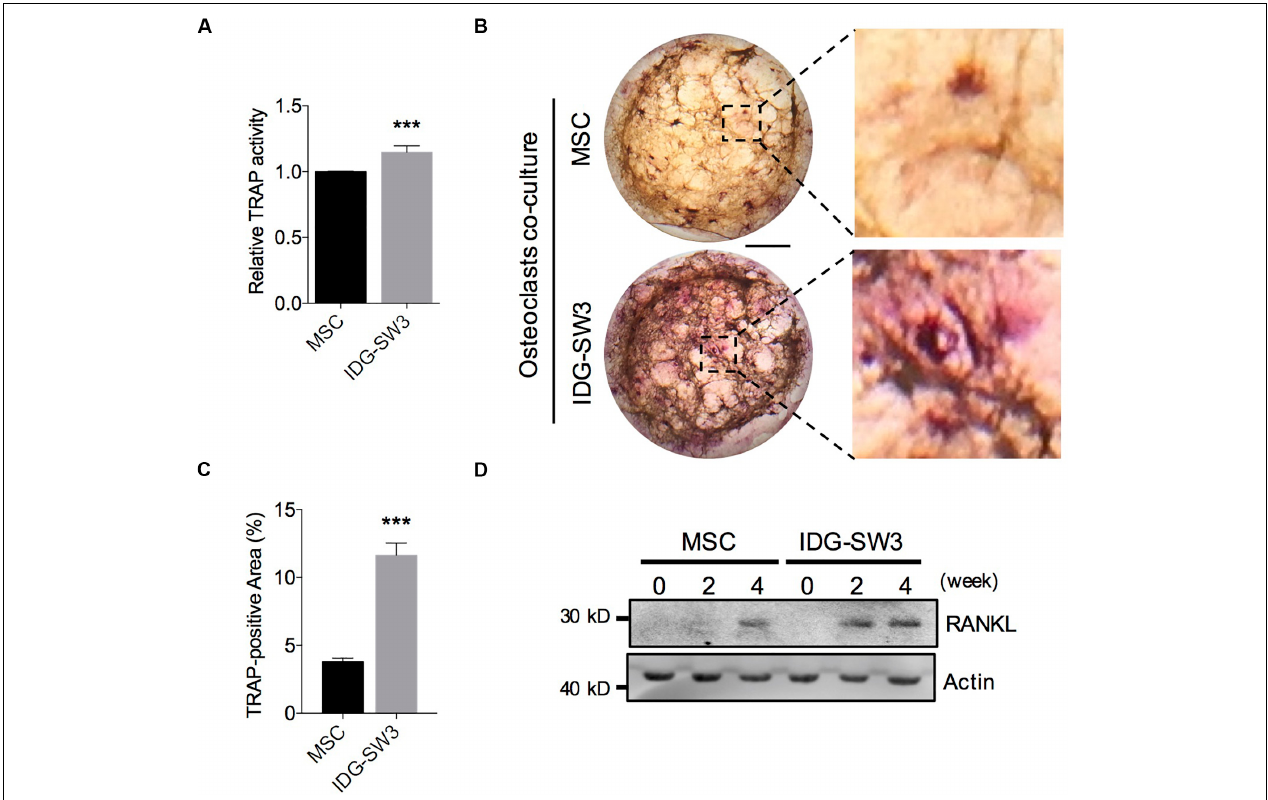
FIGURE 4 | IDG-SW3 cells promote osteoclast activation and RANKL expression. Relative TRAP activity (A) , representative TRAP staining images (B) , and TRAP-positive area analysis (C) of the osteoclasts co-cultured on 3D gels containing IDG-SW3 cells or BMSCs. (D) The content of RANKL protein expressed in 3D gels containing IDG-SW3 cells or BMSCs over differentiating time. Bar, 2 mm. Data were represented as means ± s.e.m. *** P <